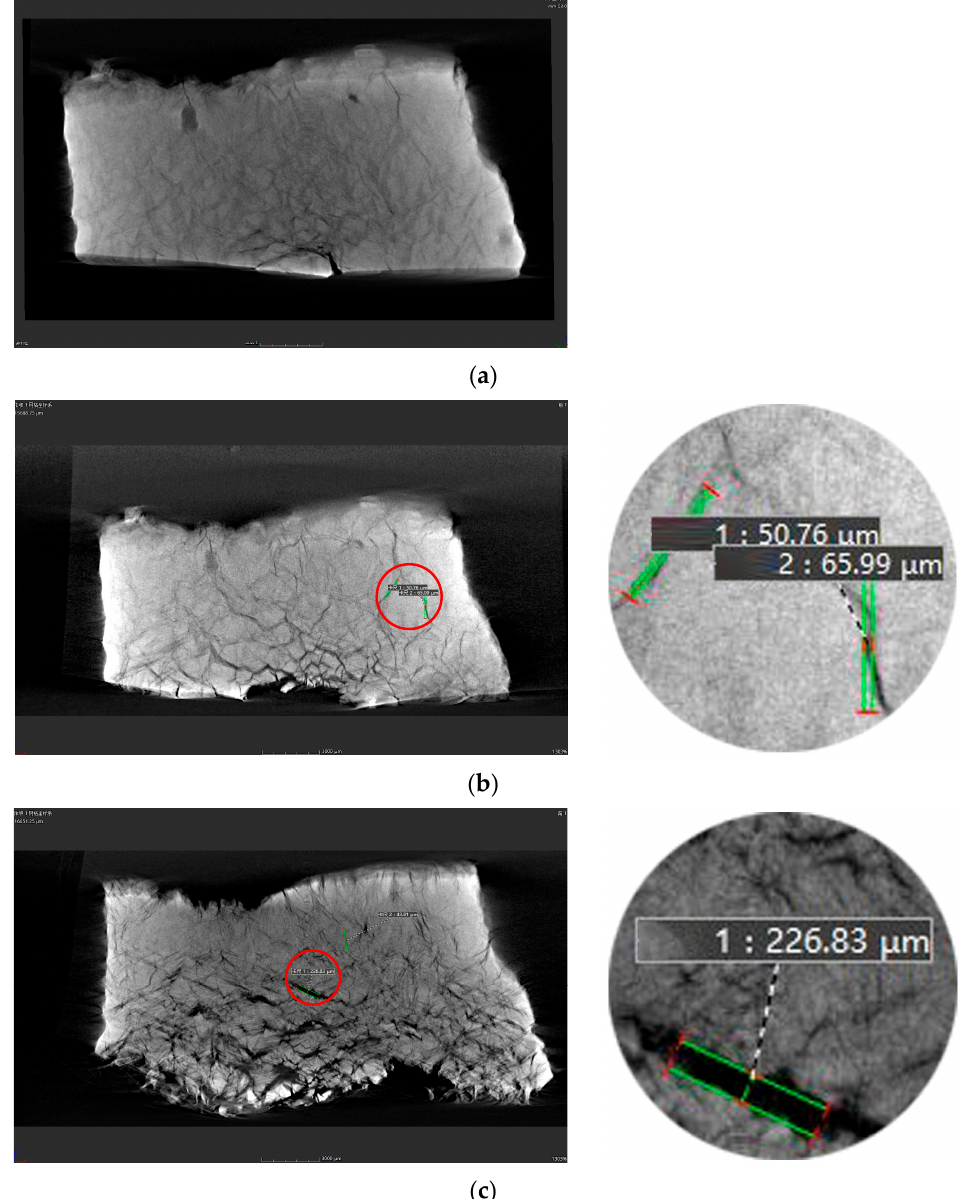
Figure 6. Micro-CT images of the development of inner fractures in the sample matrix. ( a ) Initial. ( b ) 15 days later. ( c ) 60 days later.